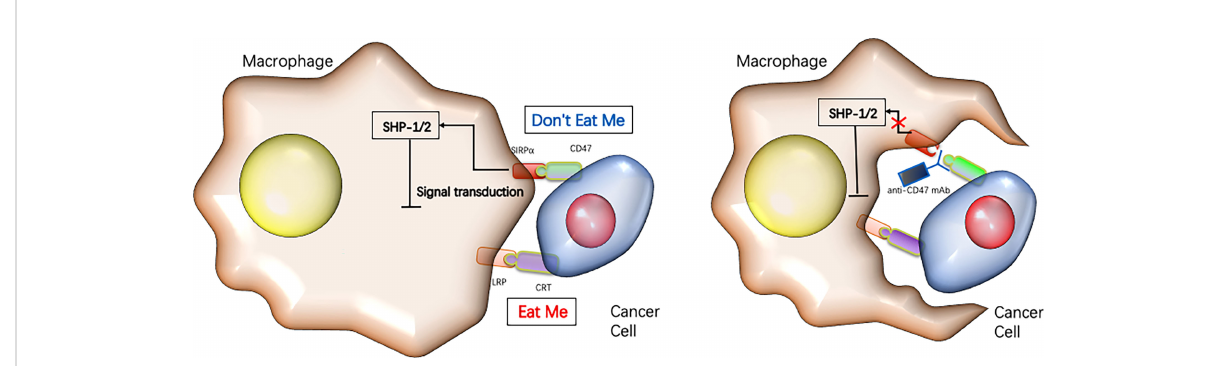
FIGURE 4 Targeting CD47 immune checkpoint for cancer immunotherapy.Cancer cells rely on the expression of “ don ’ t eat me ” signals such as CD47 to inhibit their phagocytotic clearance by macrophages, while blocking CD47 reduces tumor growth by enabling macrophages to phagocytose the cancer cells [reviewed in refs (22)].